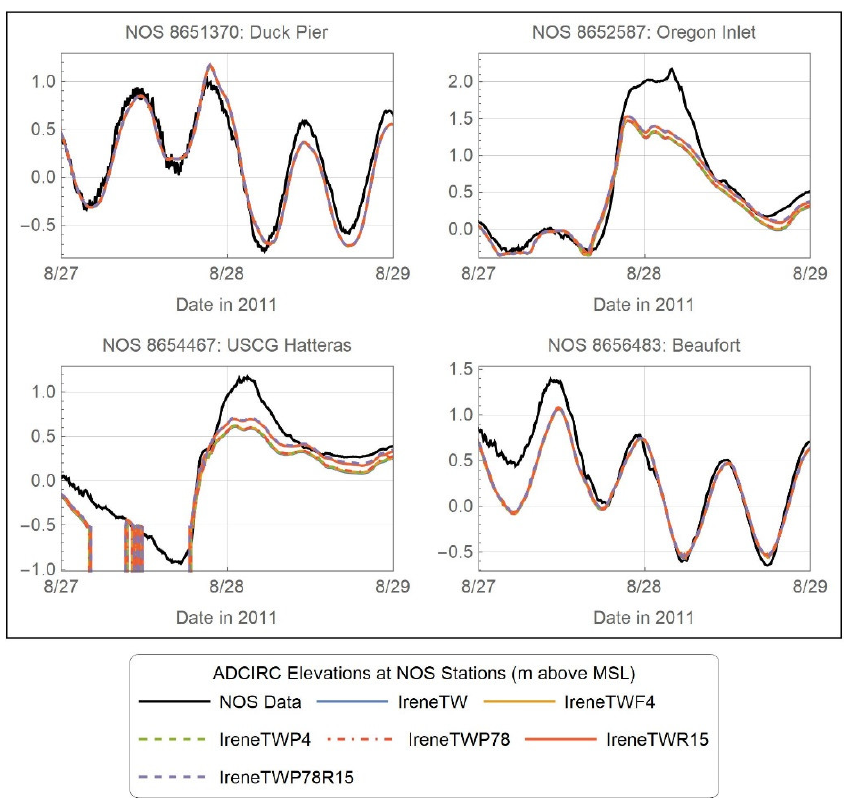
Figure 15. Comparison of modeled water heights for all additional input source combinations relative to observations at the available NOS stations (focused on timing of peak surge).